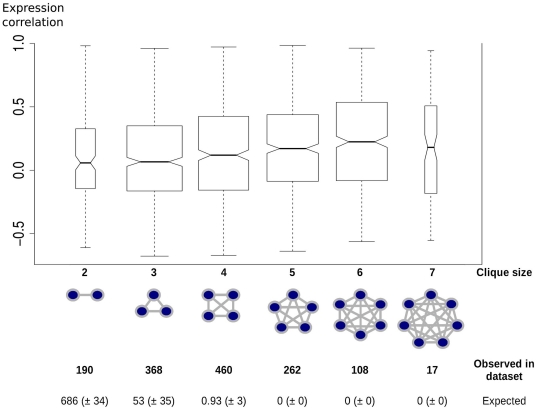
Gene expression coordination within cliques as a function of clique size.The width of the box plots is proportional to the number of connections involved in cliques of a given size. The number of observed cliques of sizes 2 to 7 is reported, as well as the numbers in randomized networks (mean, +/− standard deviation), in the form of a table at the bottom. Randomized networks are generated so that they have the same degree distribution as the original network (see Materials S1).